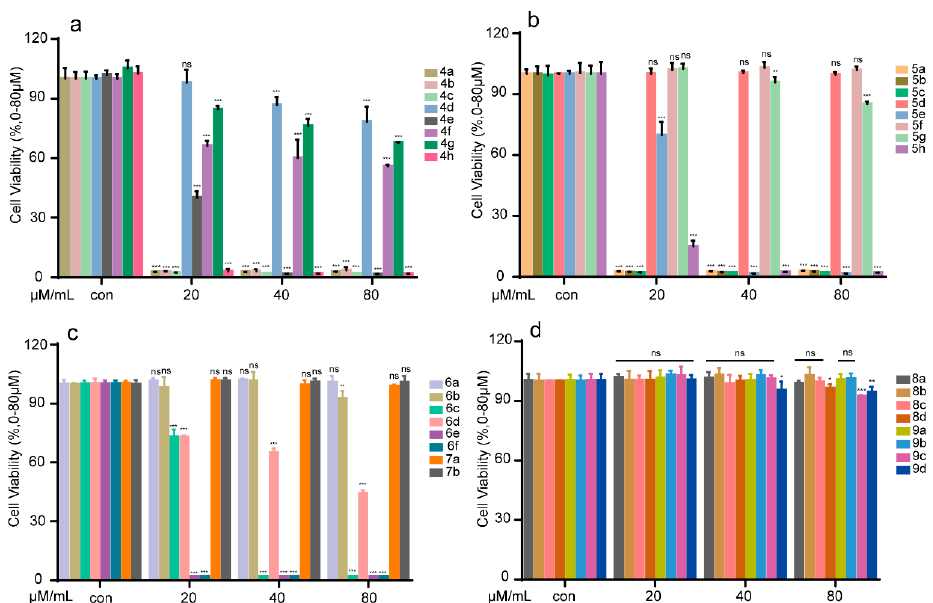
Figure 5. Representation of cell viability assay of benzofuran-heterocycle hybrids 4a – 4h ( a ); 5a – 5h ( b ); 6a – 6f and 7a – 7b ( c ); and 8a – 8d and 9a – 9d ( d ) on RAW264.7. RAW264.7 cells were treated with the compounds (0–80 μ M) for 24 h, and the cell viability was detected by MTT assay. All the experiments were independently performed three times. * p < 0.05, ** p < 0.01, and *** p < 0.001 compared to the control group.